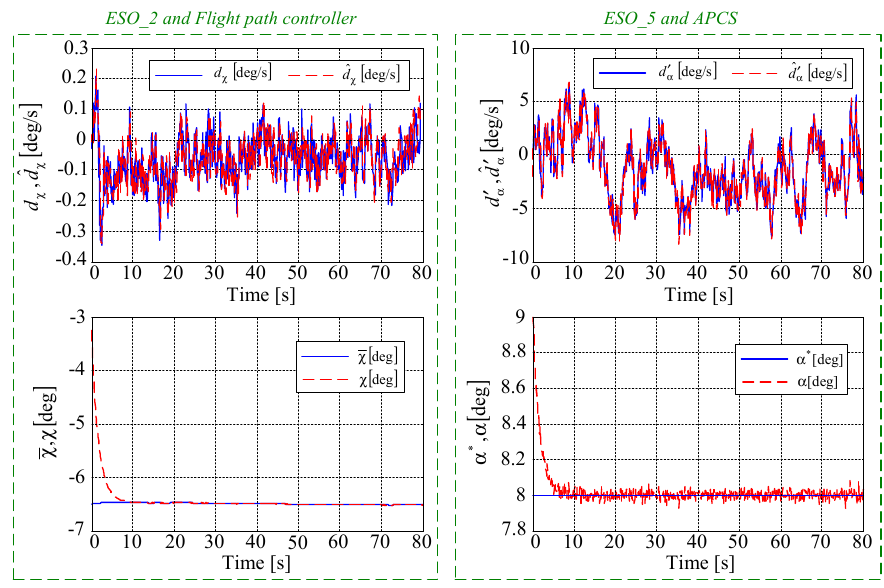
Figure 9. Time histories of the variables associated to the flight path control and APCS.